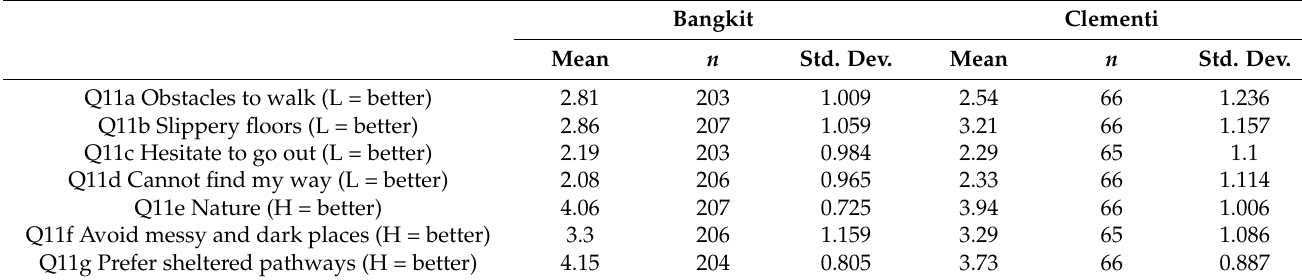
Table 11. Comparison of overall walking experience assessment (Question 11 of Socio-sensory Survey, Appendix A). Bangkit Clementi Mean n Std. Dev.